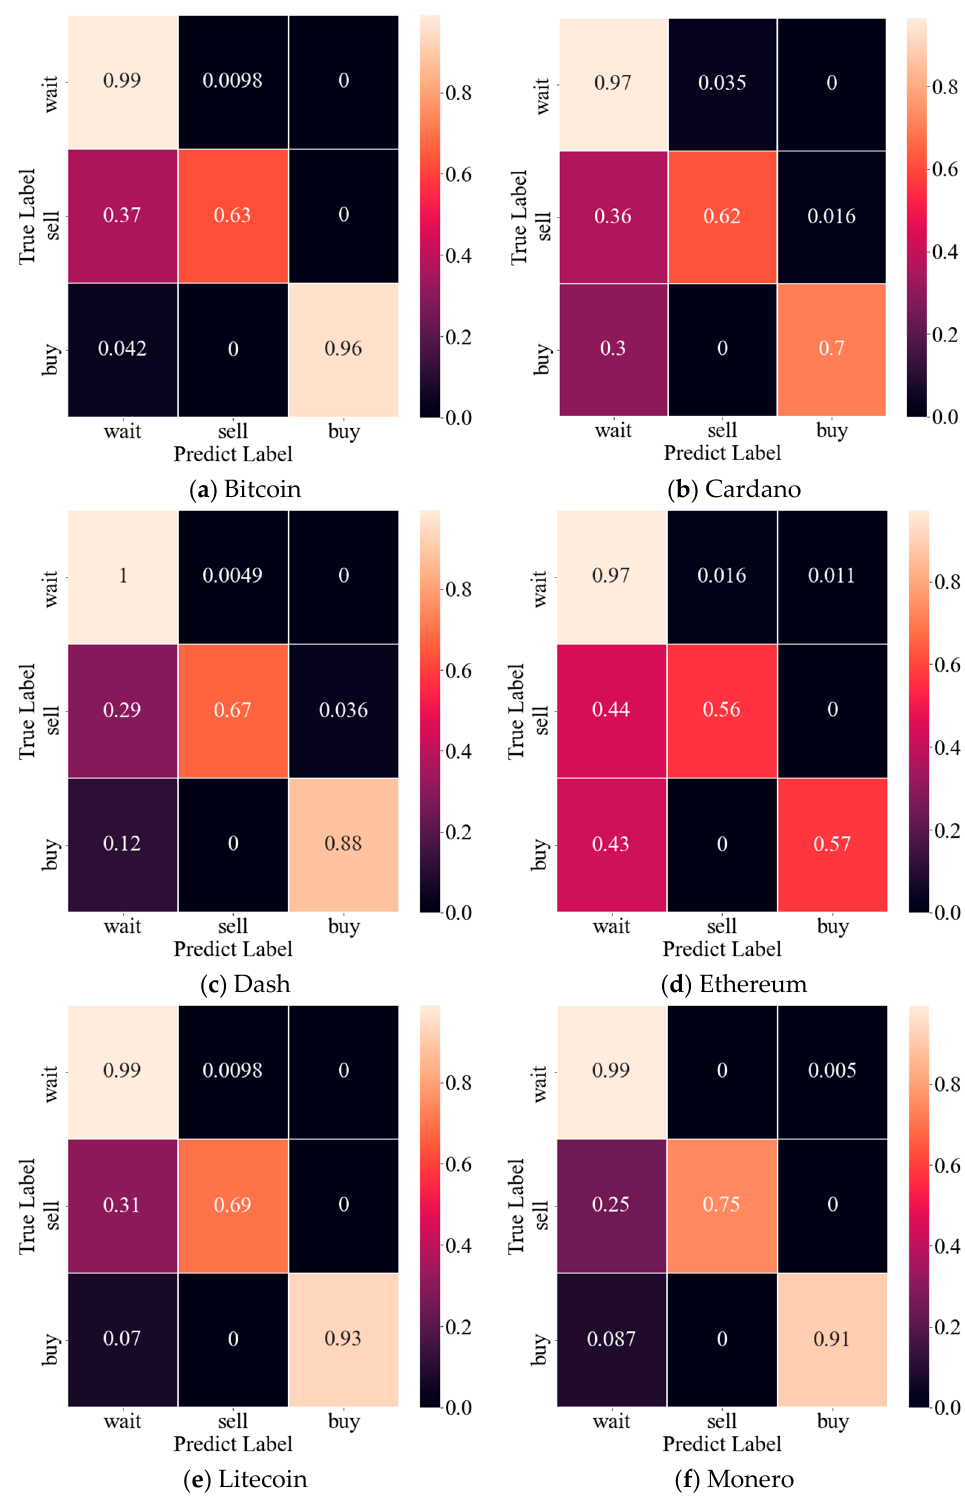
Figure 8. Confusion matrix of each cryptocurrency’s class. ( a ) Bitcoin; ( b ) Cardano; ( c ) Dash; ( d ) Ethereum; ( e ) Litecoin; ( f ) Monero.